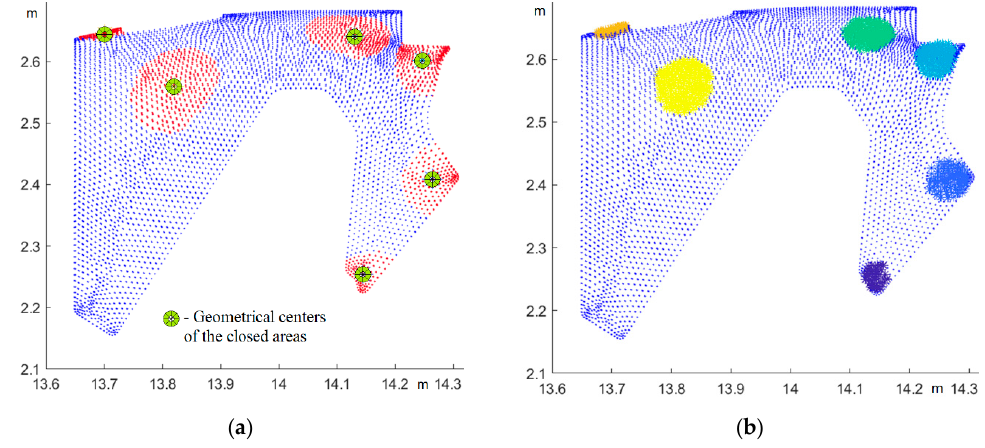
Figure 23. Determination of the geometrical centers for all closed spots ( a ) and their final dimensions after contraction ( b ).